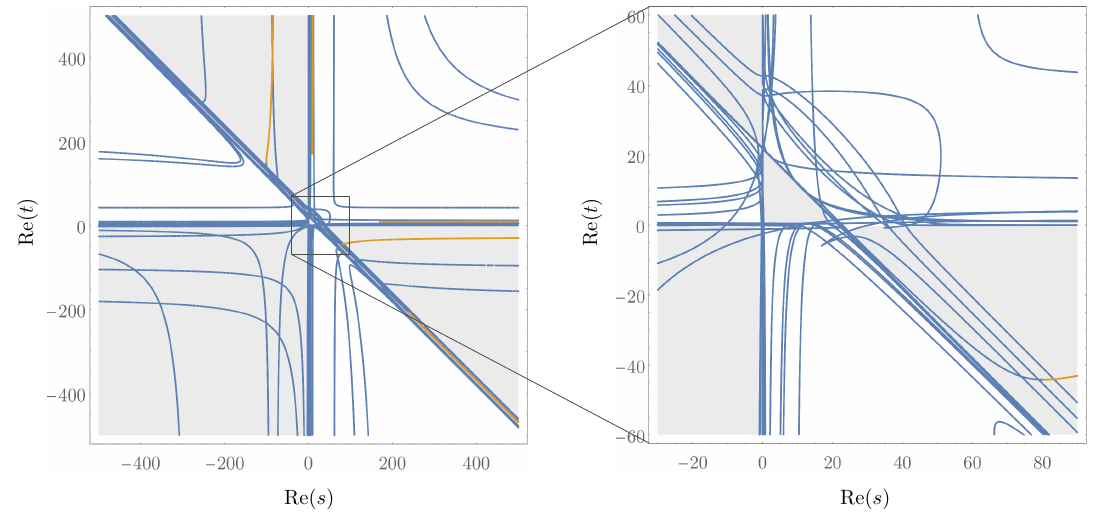
Figure 4. Leading Landau singularities for G = env with masses (3.27) at two different magnifica- tions, featuring α -positive (orange) and non- α -positive (blue) curves. Physical regions P G have 4 disconnected components (gray). There are 3 α -positive curve segments intersecting P G , also known as physical-sheet